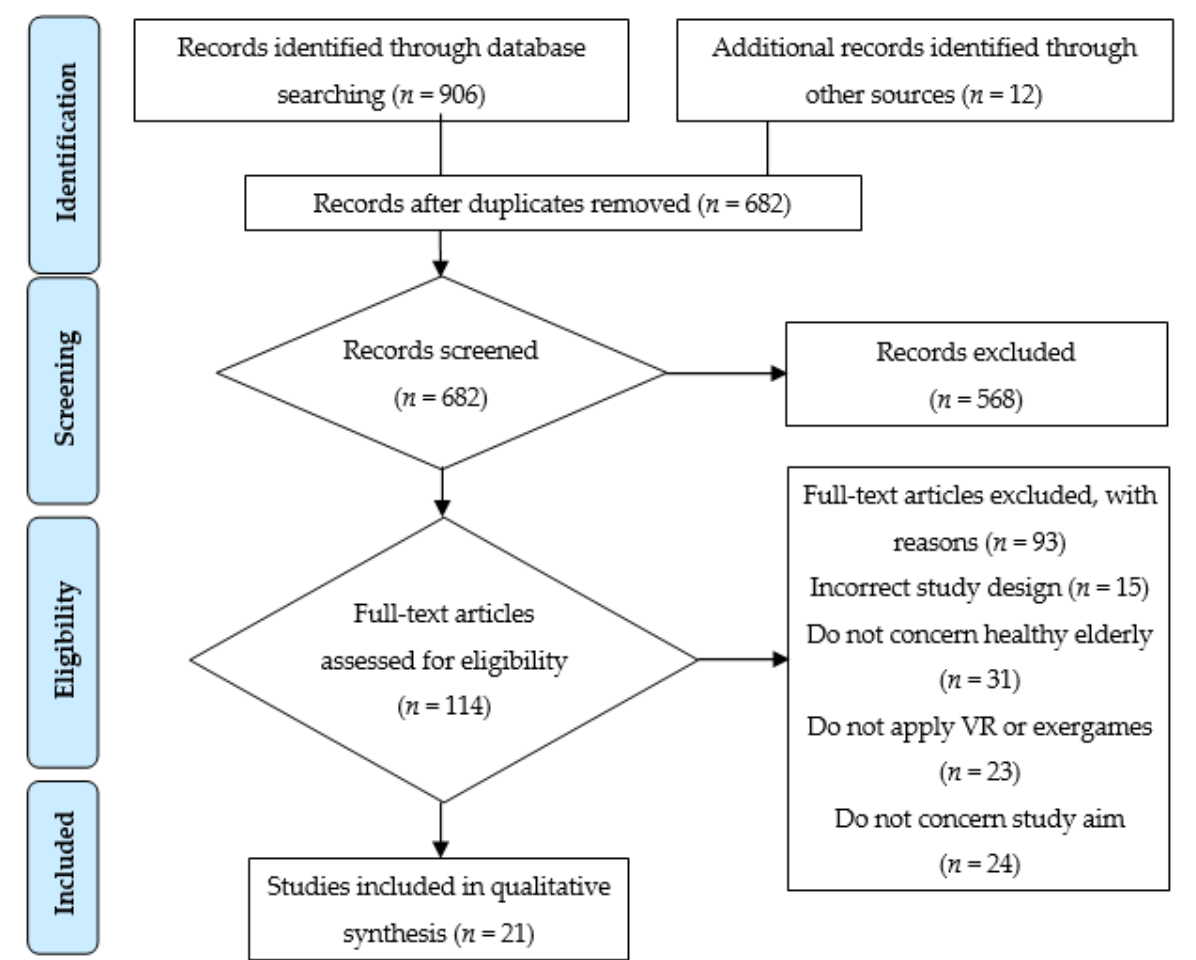
Figure 1. Flowchart of the article selection process (2009 Preferred Reporting Items for Systematic Reviews and Meta-Analyses (PRISMA) flow diagram).